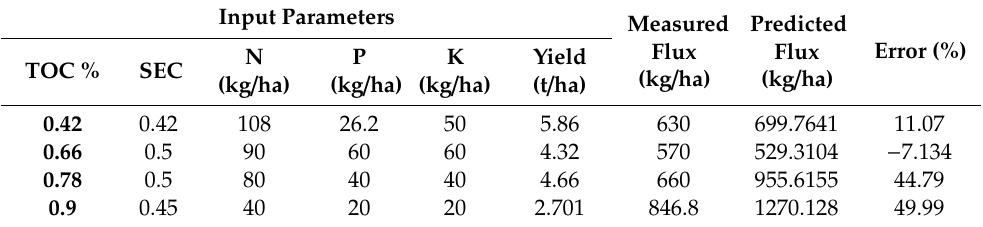
Table 7. Nitrous oxide fluxes predicted for four independent datasets that were not used for training the model.